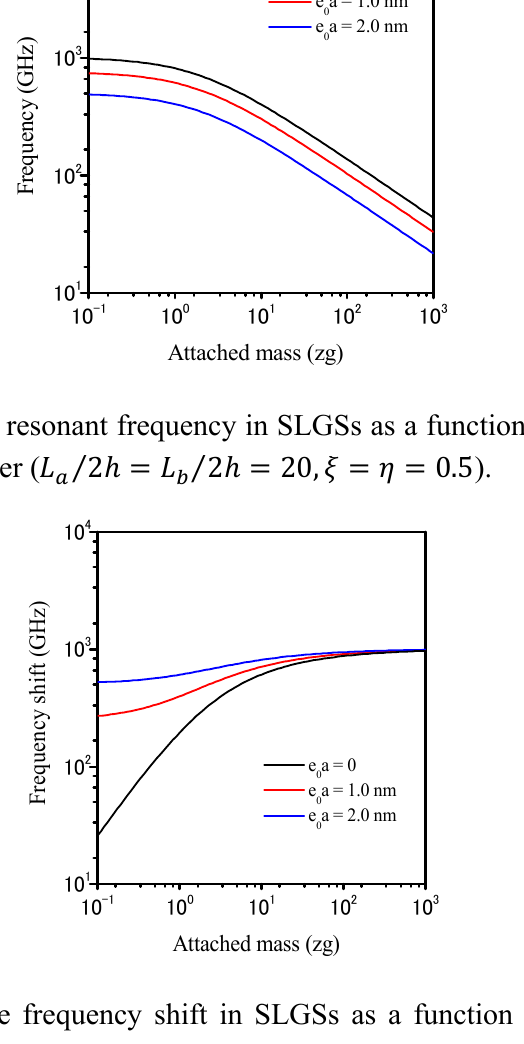
2ℎ = (cid:1838) 2ℎ = 20, (cid:2022) = (cid:2015) = 0.5⁄⁄ (cid:3028) (cid:3029)